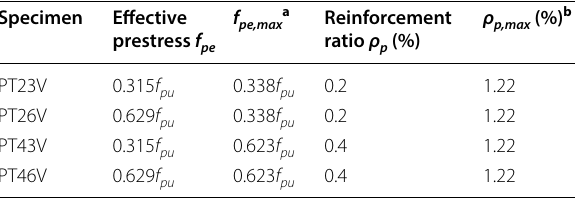
Table 1 Design parameters of PSC belt wall